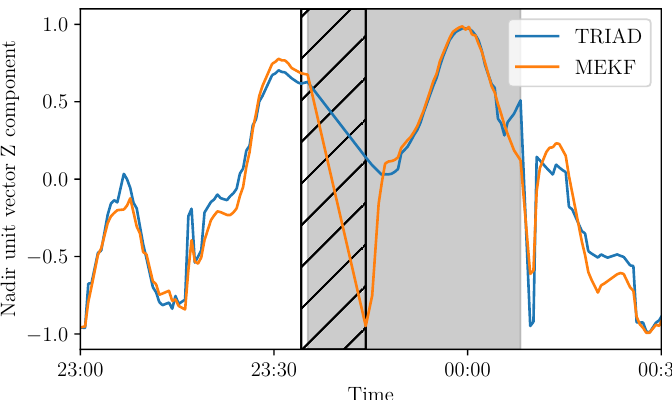
Figure 14. Uncertainties estimated from the Monte Carlo method for TRIAD and MEKF methods for continuous sampling on 2 March 2021 ( top ) and from 11–13 March 2021 ( bottom ) with eclipse phases in gray.